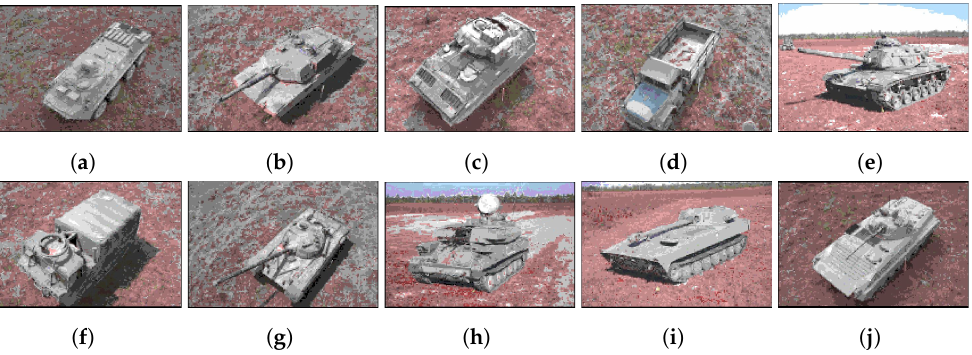
Figure 3. Electro-optical images corresponding to the MSTAR dataset used in this paper; ( a ) BTR70, ( b ) M1, ( c ) M2, ( d ) M35, ( e ) M60, ( f ) M548, ( g ) T72, ( h ) ZSU23-4, ( i ) 2S1, ( j )